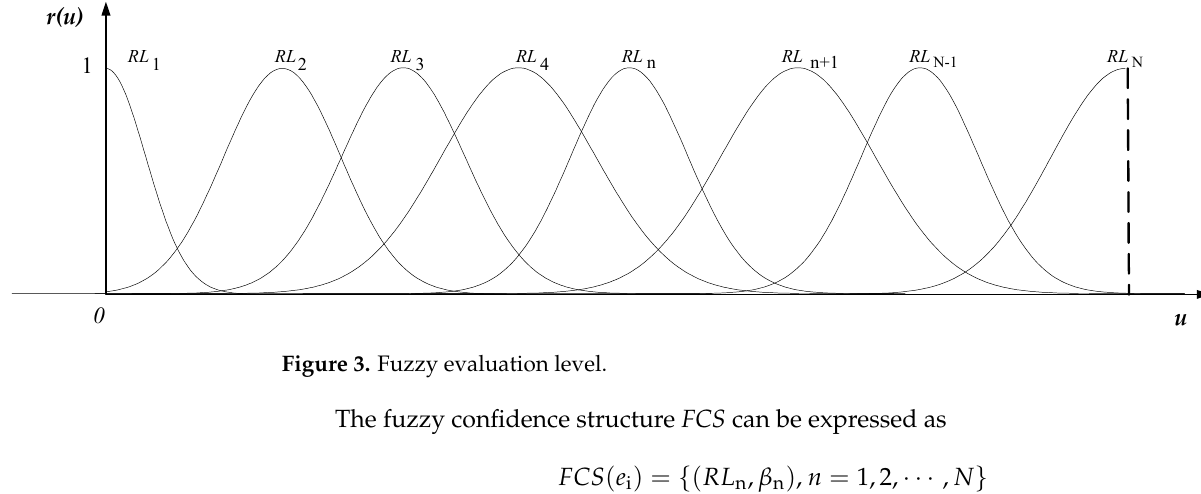
Figure 2. Affiliation-degree comparison of the fuzzy normal distribution and the triangular distribution.